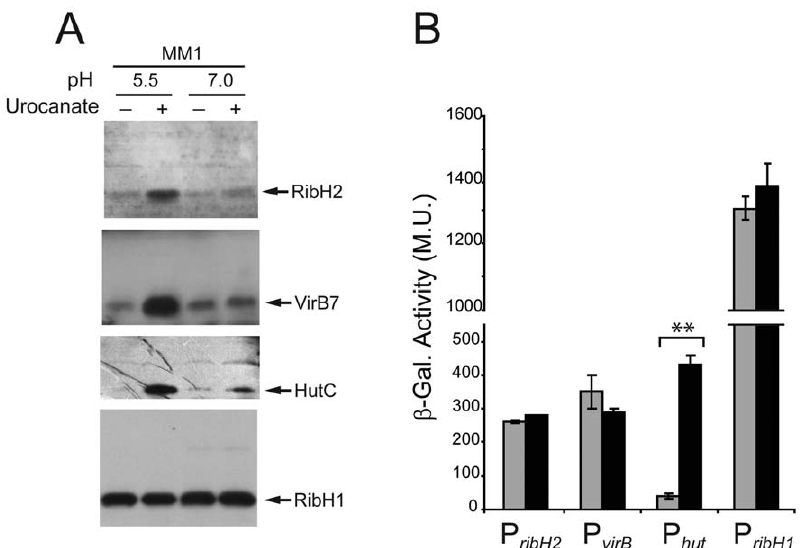
Figure 4. Urocanic acid also induced expression of other Brucella virulence-associated proteins. (A) Samples corresponding to B. abortus 2308 grown in TSB and shifted to MM1 at pH 5.5, or 7.0 in the absence or presence of 5 mM urocanic acid; were analyzed by western blot using anti- RibH2, anti-VirB7, anti-HutC or anti-RibH1 antibodies. (B) Analysis of ribH2 (P ribH2 ), virB (P virB ), hut (P hut ), or ribH1 (P ribH1 ) promoter activity. Strains B. abortus P ribH2 - lacZ , B. abortus P virB - lacZ , B. abortus P hut - lacZ , or B. abortus P ribH1 - lacZ were grown in TSB and shifted to MM1 at pH 5.5 in the absence (gray bars) or presence (black bars) of 5 mM urocanic acid. Subsequently, b -galactosidase activities were determined. Values are means 6 standard